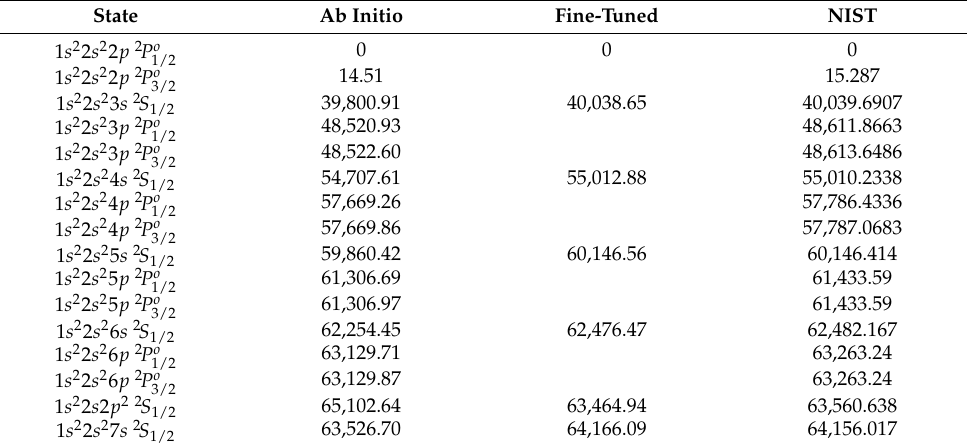
Table 4. Energies (in cm − 1 ) for B I from ab initio and fine-tuned CI calculations compared with experimental energies from the NIST database [28].